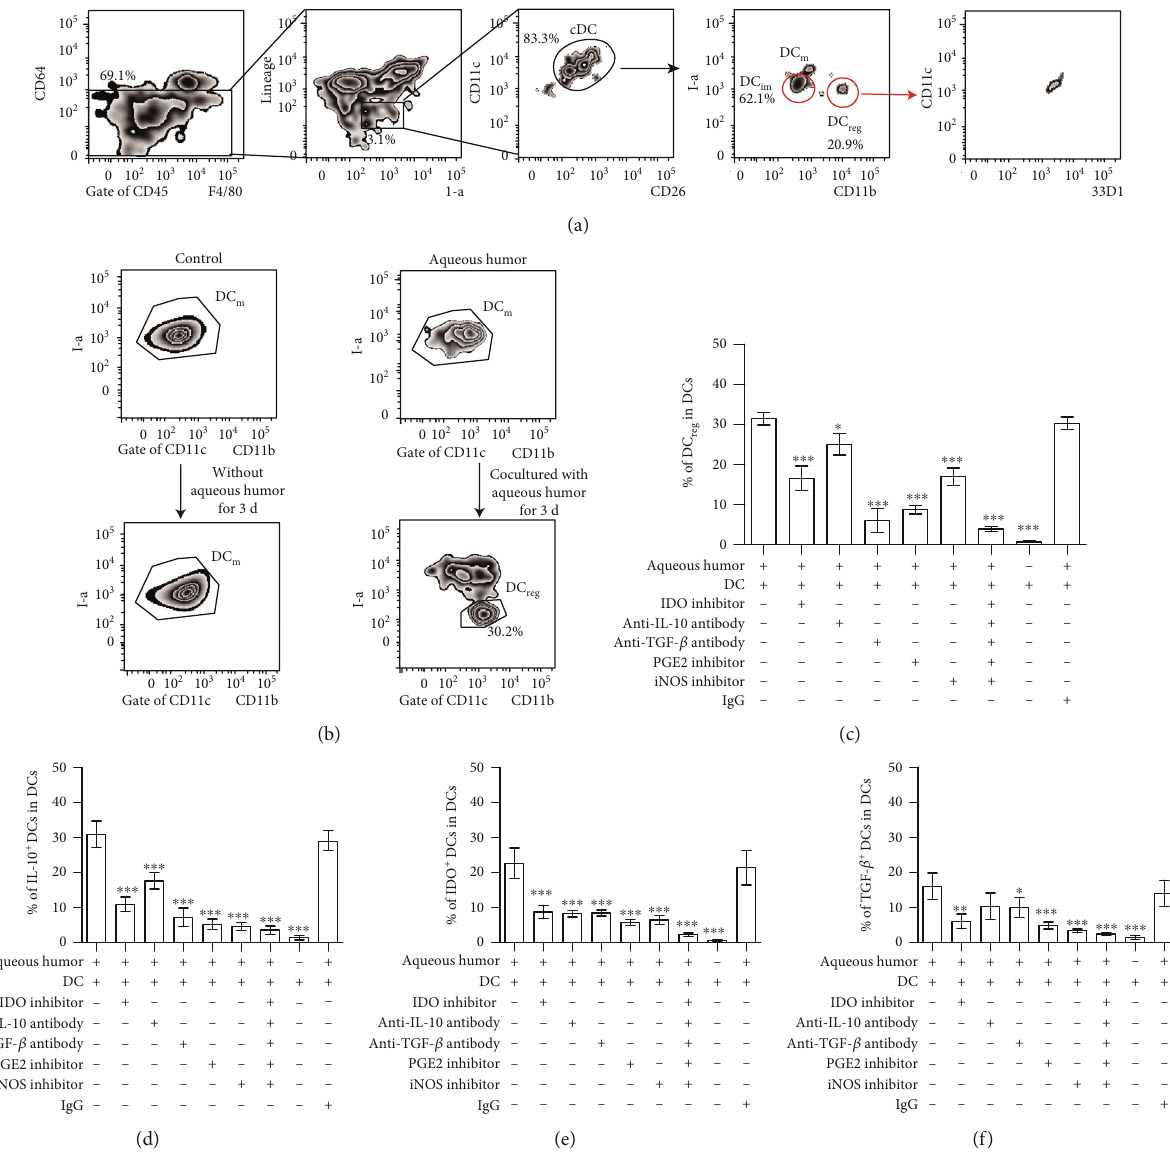
Figure 6: The status of DCs in the eyes of normal mice. (a) In addition to macrophages and monocyte-derived cells, CD3 + T cells, CD19 + B cells, and NK1.1 + natural killer (NK) cells (lineage mix) were also excluded. The representative I-a low CD11b high DCs (DC ) in ocular cells reg from normal eyes were detected by fl ow cytometry. (b) The representative diagram of I-a low CD11b high regulatory DCs was in the culturation . I-a high CD11b low DCs (DC ) were isolated and were stimulated by aqueous humor (100 μ l/ml, right) or not (control). After 3 days, of DC m m DC was detected in the culturation of DC . (c) The percentage of DC in the culturation of DC , which is with aqueous humor added reg m reg m with anti-IL-10 antibody, anti-IDO antibody, anti-TGF- β antibody, anti-NO antibody, anti-PGE2, or the whole antibody, compared with those without treatment. DCs were isolated from the spleen of normal mice. (d – f) The percentage of IL-10 + DCs, IDO + DCs, and TGF- β + DCs in the culturation of DC , which is with anti-IL-10 antibody, anti-TGF- β antibody, IDO inhibitor, NO inhibitor, PGE2 inhibitor, or m the whole antibody or inhibitor stimulation, were added, compared with those without treatment. (d – f) Experiments were replicated three times, data were presented as mean ± standard errorof the mean (SEM), and ∗ P < 0 : 05 , ∗∗ P < 0 : 01 , and ∗∗∗ P < 0 : 001